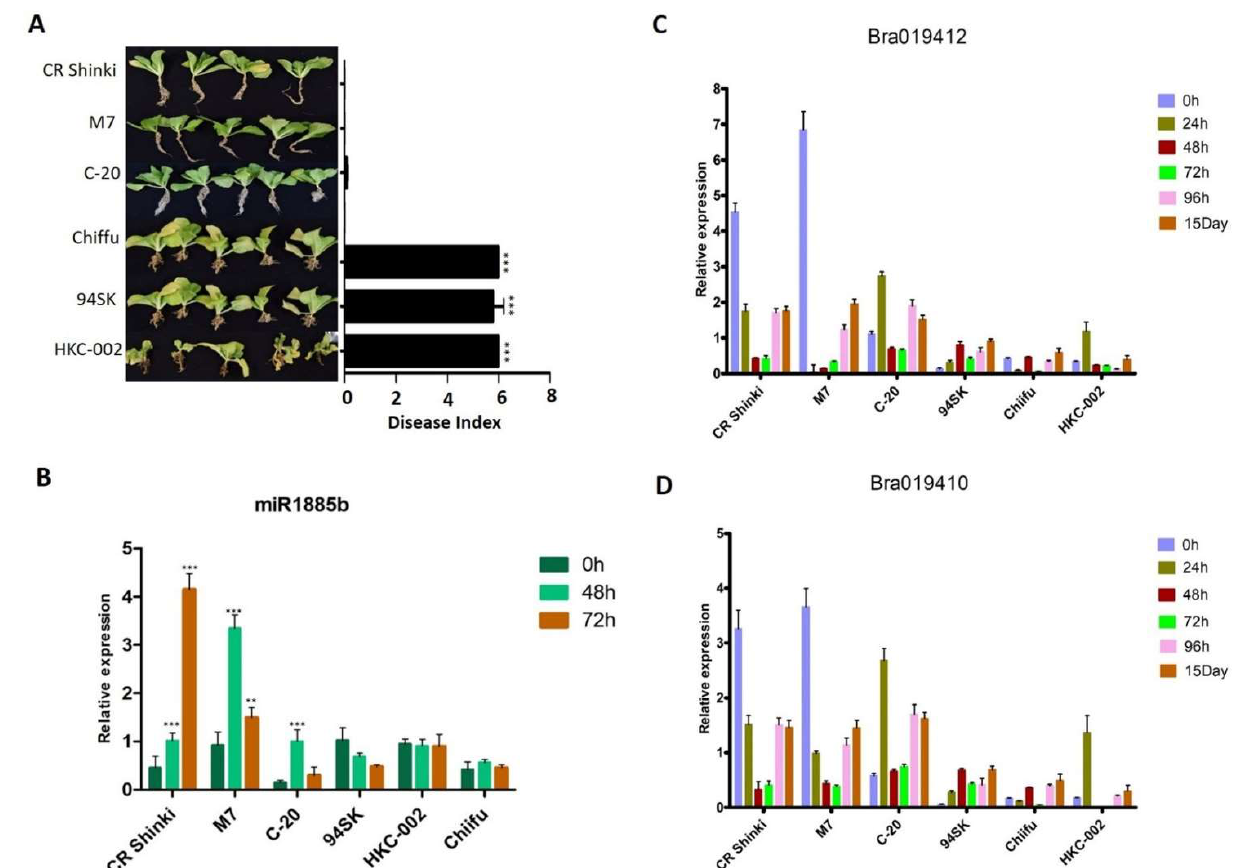
Figure 6. Expression patterns of miR1885b, Bra019412 , and Bra019410 in multiple resistant and susceptible lines. ( A ) Effects of the P. brassicae Race 4 infection of resistant (CR Shinki, M7, and C-20) and susceptible (94SK, HKC-002, and Chiifu) genotypes with the same alleles. Disease symptoms were examined at 8 weeks post-inoculation. For each line, the disease index, calculated according to the disease severity, is provided to the right of the photos. Bars represent the standard error. Significant differences are indicated with asterisks (* p < 0.01, ** p < 0.05, and *** p < 0.001). Expression of ( B ) miR1885b, ( C ) Bra019412 , and ( D ) Bra019410 in resistant (CR Shinki, M7, and C-20) and susceptible (94SK, HKC-002, and Chiifu) genotypes. For each time-point, the expression levels were calculated on the basis of three independent replicates.